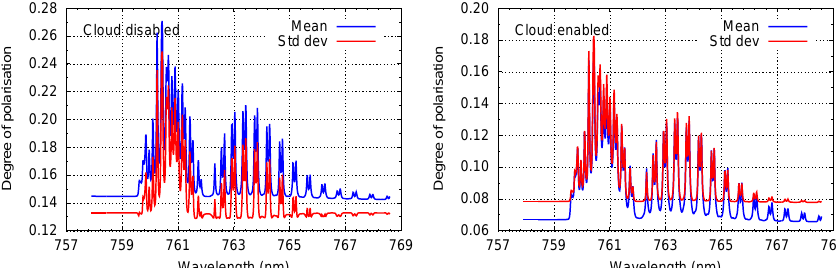
Figure 9. Mean and standard deviation of the degree of polarisation simulated at the top of the atmosphere in the O 2 A-band. In the left-hand panel the soundings with cloud were discarded, so the sources of polarisation are the surface and scattering by aerosols and molecules. The right-hand panel applies to soundings with